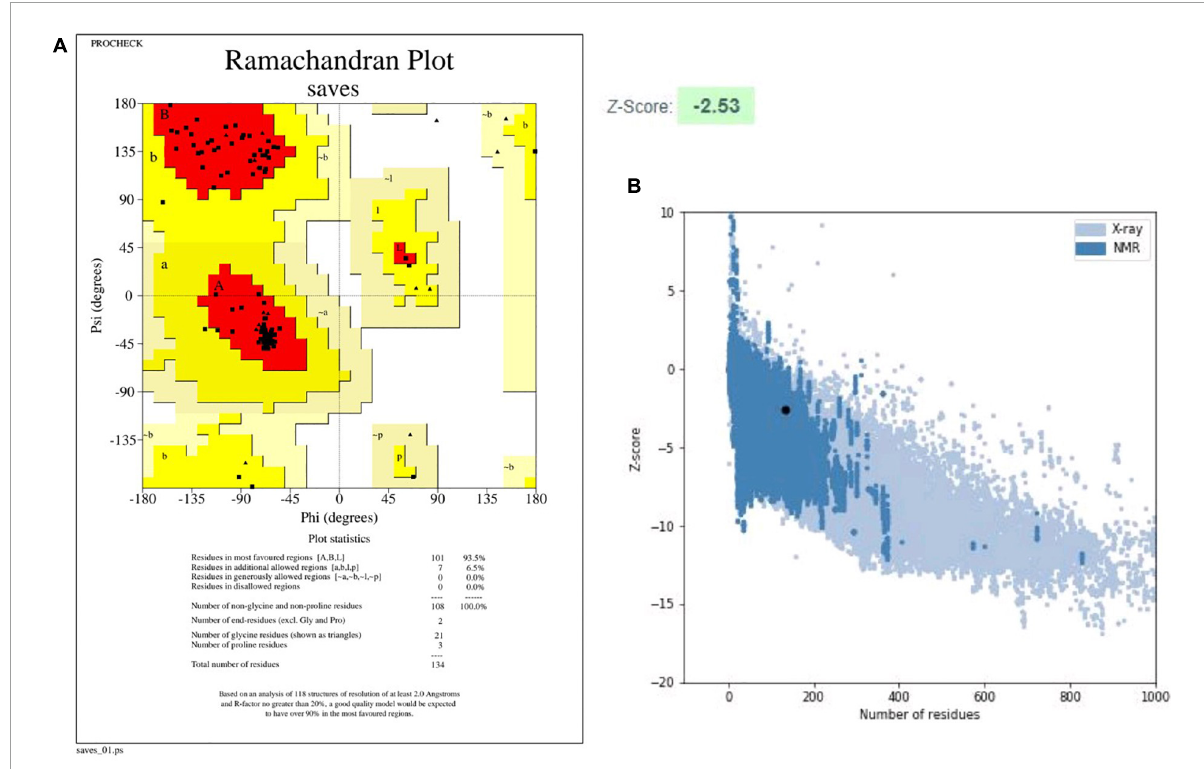
FIGURE3 Validation results for the designed tertiary structure of vaccine construct (V2). (A) Ramachandran plot, (B) ProSA web